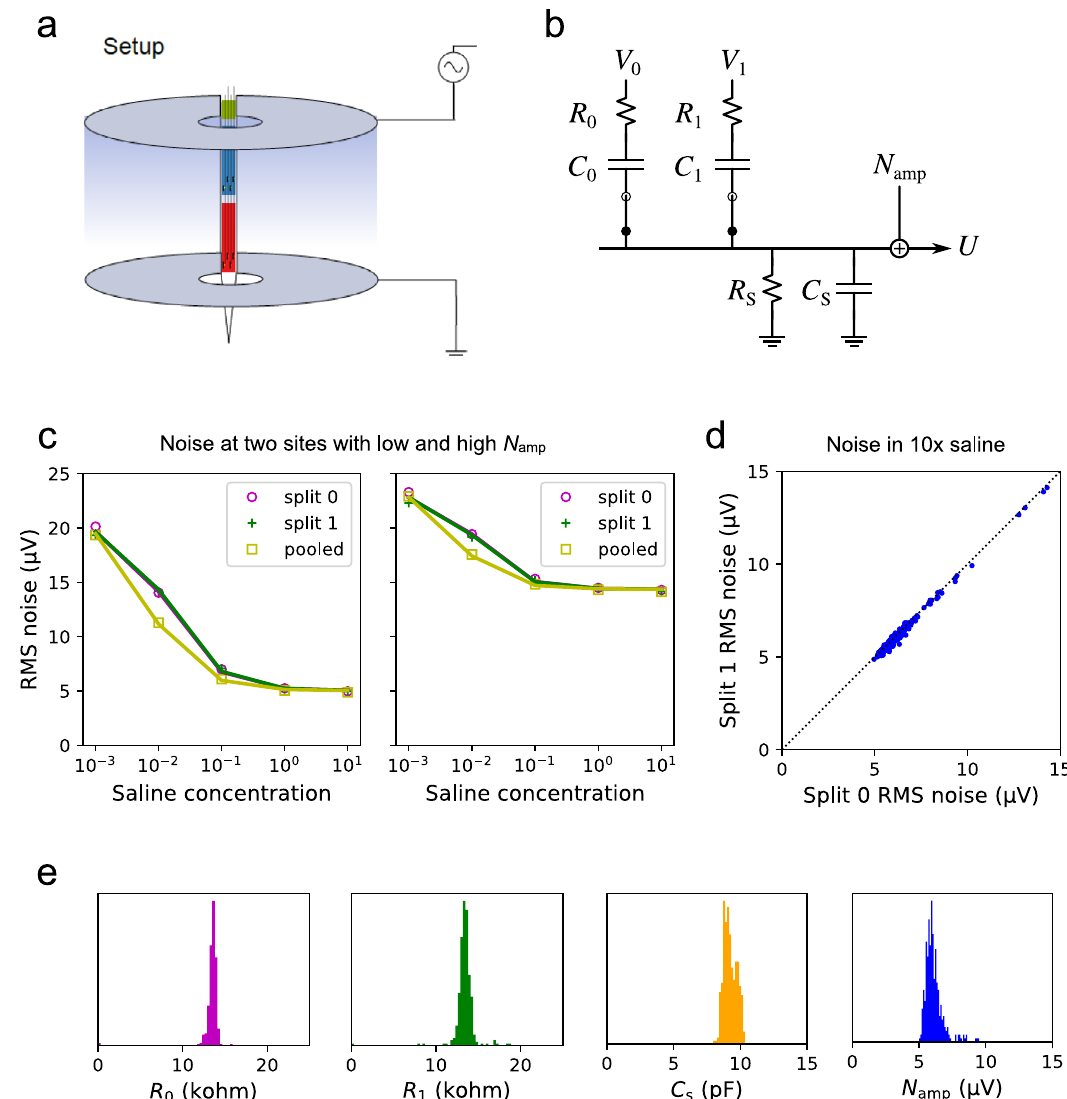
Fig. 8 Methods for in vitro measurements of Neuropixels function. a The probe is immersed in saline, with two annular electrodes producing an electric gradient along the shank. b Equivalent circuit model to understand signal and noise pooling for one wire of the array. c Measurements of noise only without an external fi eld. RMS noise as a function of the saline concentration under three conditions of the switches: split recording from Bank 0, split recording from Bank 1, and pooled recording from both. Examples of two different wires, one with high, the other with low ampli fi er noise N amp . d The noise at the highest saline concentration, recording from electrode 1 vs electrode 0. Each dot is for one of the 383 wires. This limiting noise is identical across the two electrodes on the same wire. e Histograms of the best- fi t circuit parameters derived for each of the 383 wires on a pristine Neuropixels probe. R S is too large to be measured